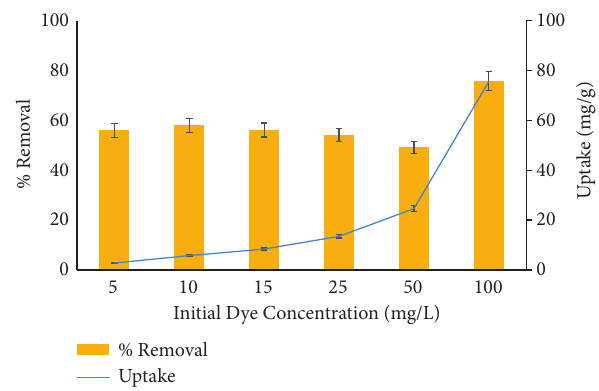
Figure 6: Effect of initial RR120 concentration on the sorption capacity and RR120